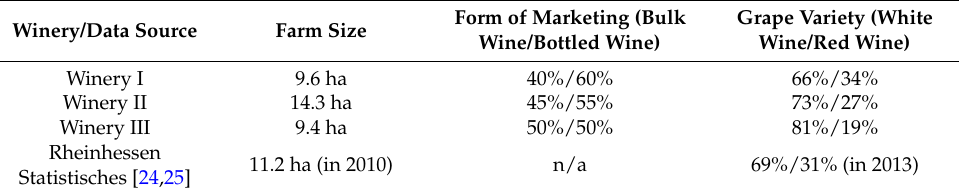
Table 1. Farm characteristics.